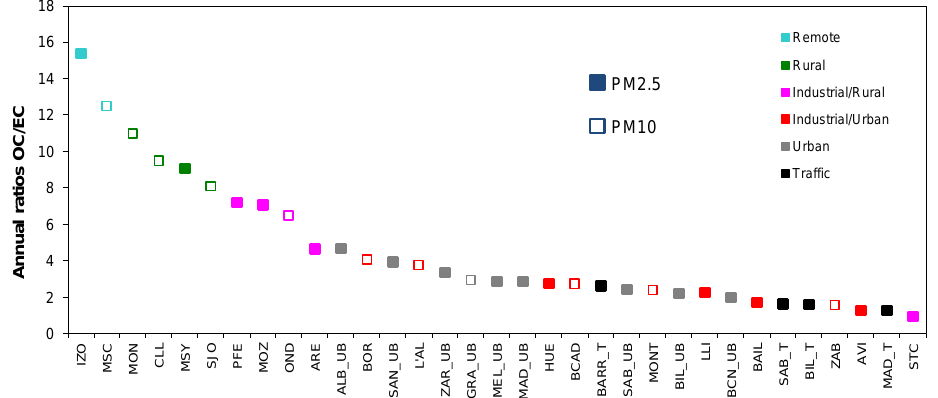
Figure 5. Mean annual OC/EC ratios in PM2.5 (solid) and PM10 (blank) recorded in the 33 study sites ordered from high to low and classified according to the site type. Fig. 5. Mean annual OC/EC ratios in PM 2 . 5 (solid) and PM 10 (blank) recorded in the 33 study sites ordered from high to low and classified according to the site